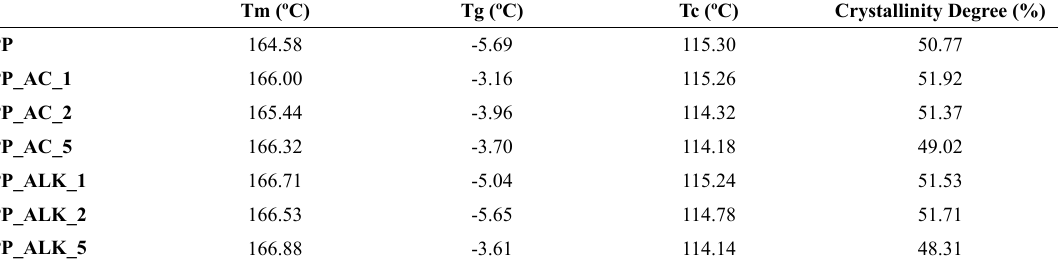
Table 5. Tm (ºC), Tm (ºC), degree of crystallinity (%) and Tg (ºC) for pure PP and PP/lignin blends.